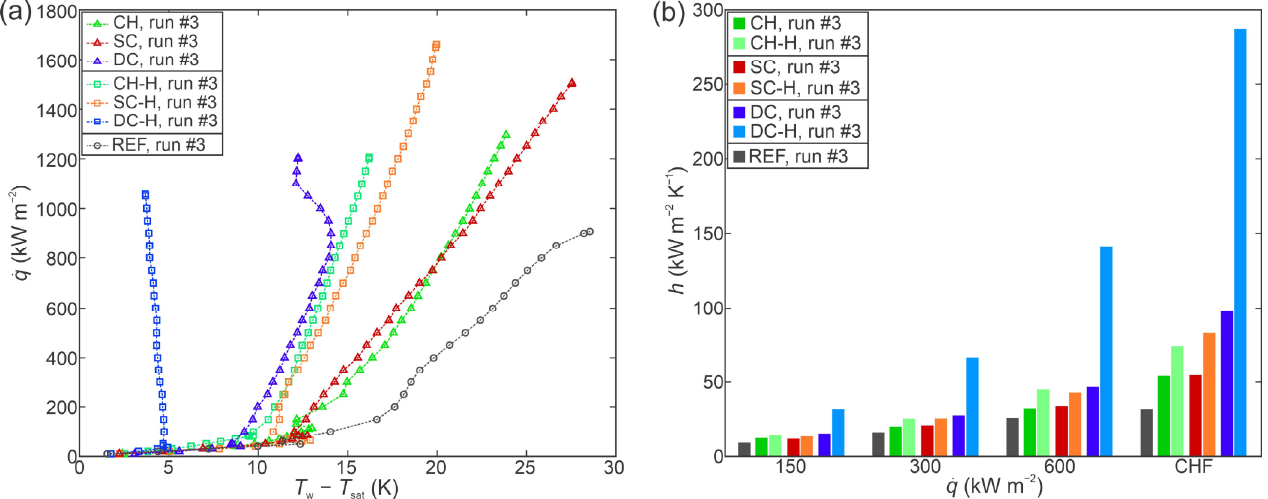
Figure 8. Comparison of boiling performance of all samples during the third experimental run through ( a ) boiling curves and ( b ) heat transfer coefficients at selected heat fluxes.